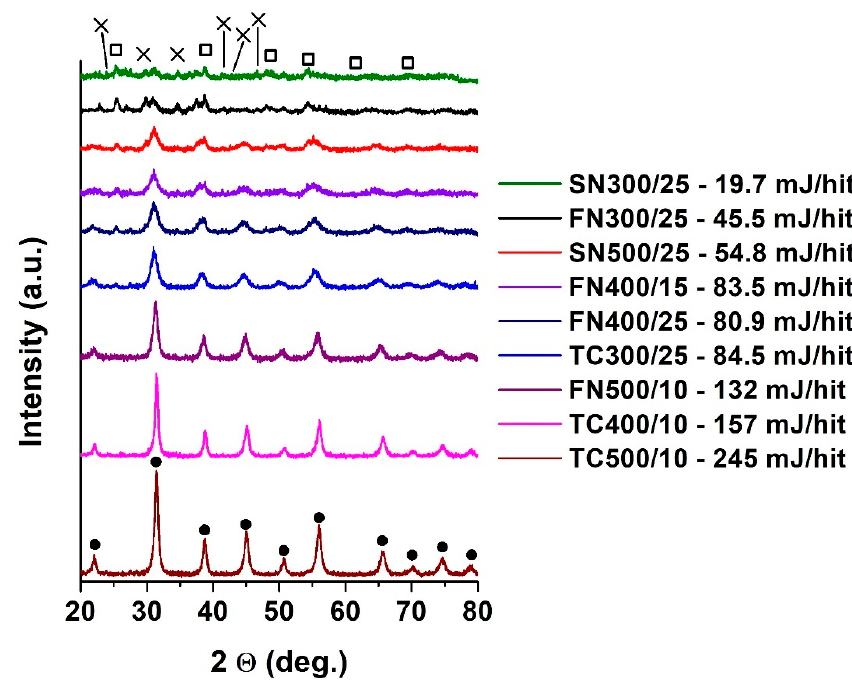
Figure 2. XRD diffractograms of all samples treated at different ball-impact energy (E b ). • : BaTiO 3 , (cid:3) : TiO × : BaO 2 ,